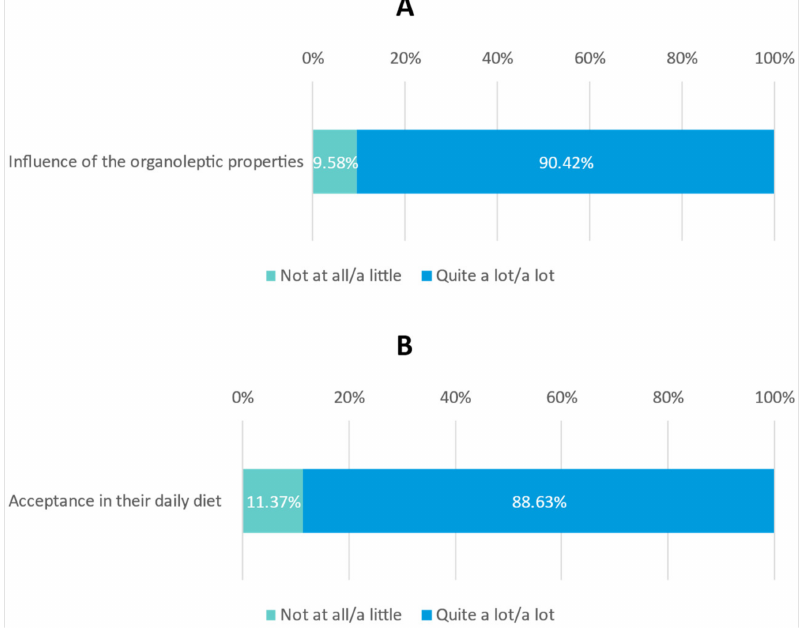
Figure 4. ( A ) Influence of organoleptic properties on patient satisfaction; ( B ) Degree of acceptance of the patient’s ONS in their daily